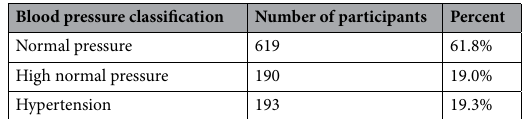
Table 1. Classification of blood pressure in the study